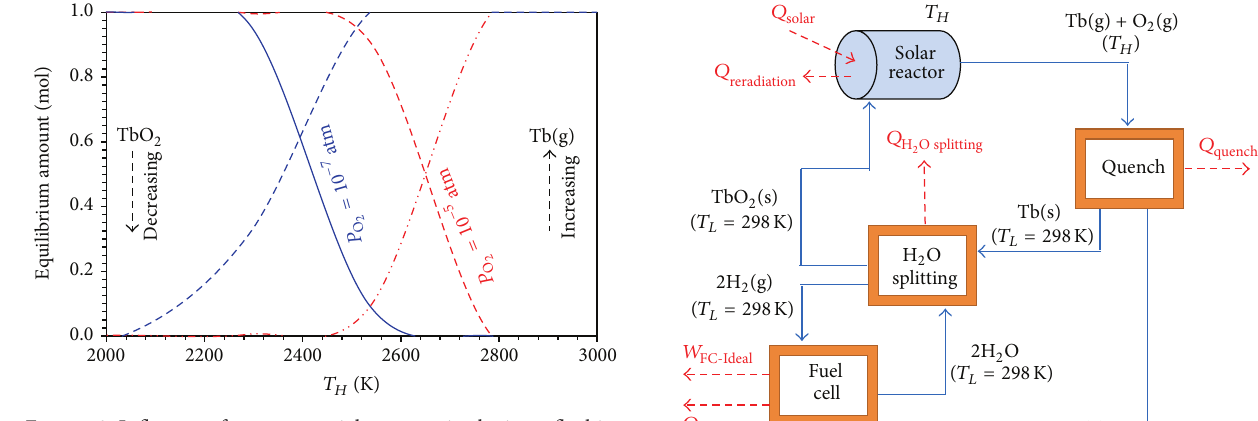
Figure 3: Influence of oxygen partial pressure in the inert flushing gas on equilibrium compositions associated with the thermal reduc- tion of TbO 2 .